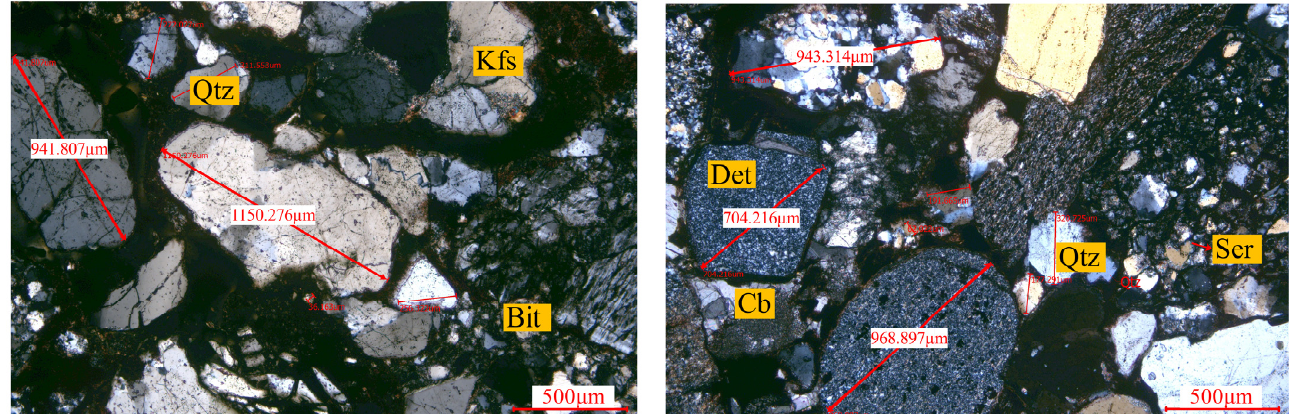
Figure 3. Images of a rock thin section observed under a polarized light microscope with a scale of 500 μ m. These mineral grains on the graph were identified according to the characteristics of the different mineral species. Det: Detritus; Qtz: Quartz; Kfs: Potash feldspar; Cb: Carbonate minerals; Ser: Sericite; Bit: Biotite.